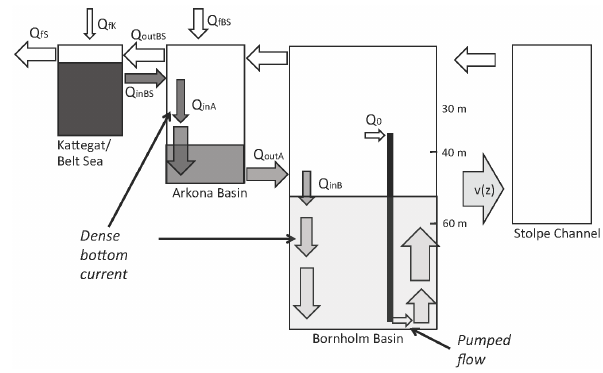
Figure 2. Schematic image of model flows. Grey is used to indicate salinity, with the saltiest water darkest. Dense bottom currents in the Arkona and Bornholm basins are shown by their vertical com- ponents. These flows increase with depth due to entrainment of am- bient water. Pumping in the Bornholm Basin is shown by a verti- cal pipe transporting winter water into the deepwater. The pump- induced flow increases due to initial mixing at the pipe outlet and thereafter by plume mixing while rising. The flows are further de- scribed in Sect.